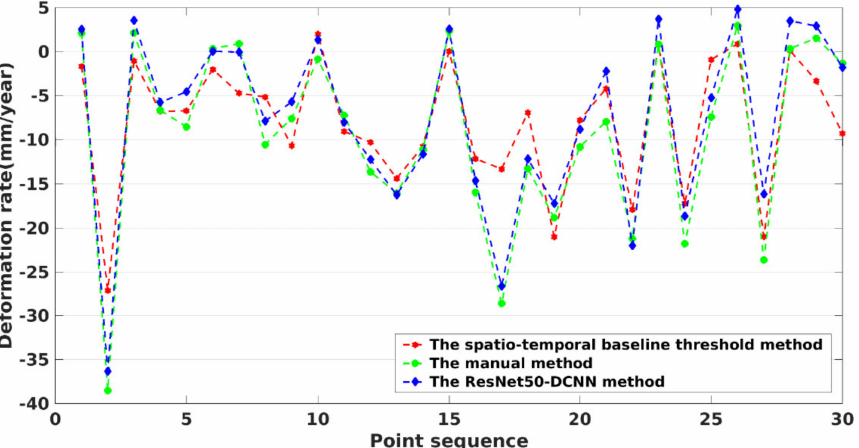
Figure 14. Annual average deformation rate of 30 randomly selected PS points obtained by the three investigated methods. See also Figure